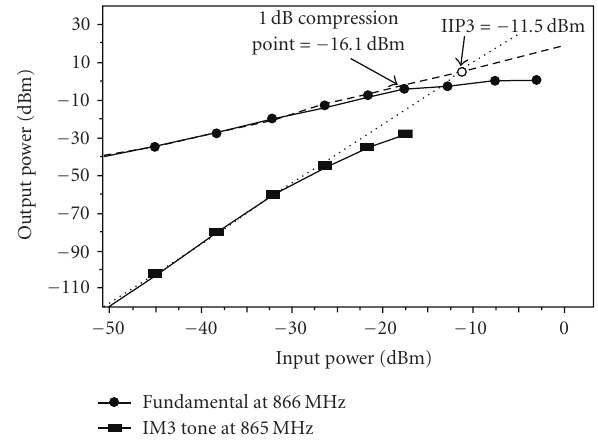
Figure 9: The IIP3 and 1 dB compression points for the UHF RFID